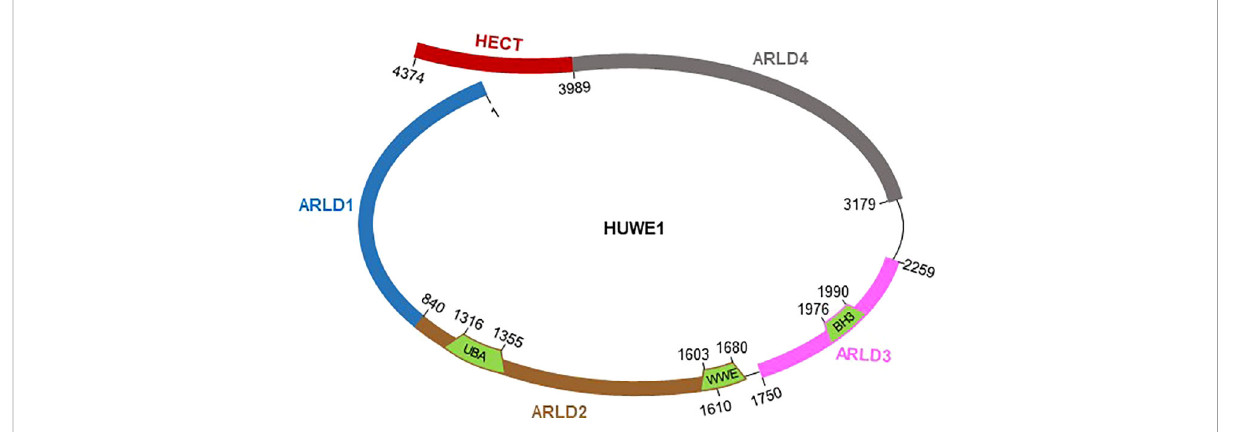
FIGURE 1 Schematic representation of full-length HUWE1 with functional domains and indicated boundaries. HUWE1 harbors a ring-shaped architecture composed of four armadillo repeat-like domains (ARLD1-4), and a fl exible C-terminal HECT catalytic